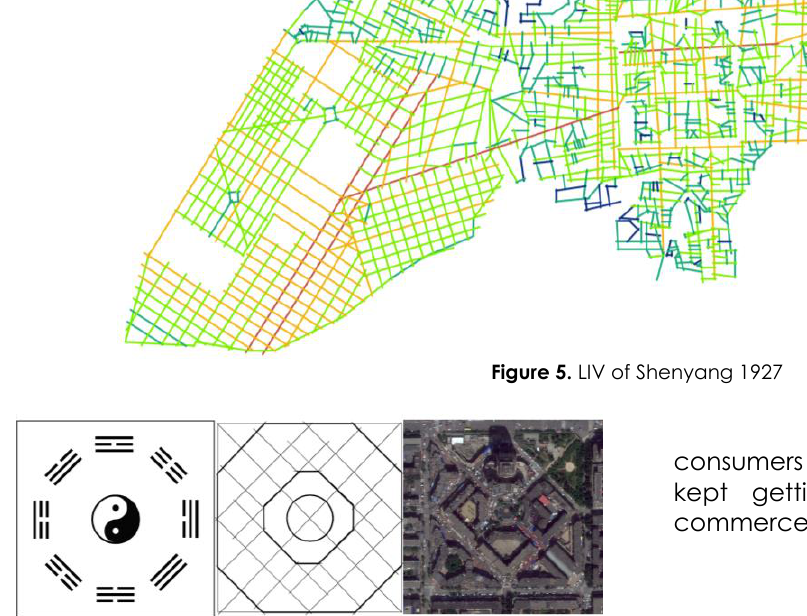
Figure 6. From left to right are (a) Eight diagrams; (b) Street structure of South Market; (c) Arial image of South Market 2 .